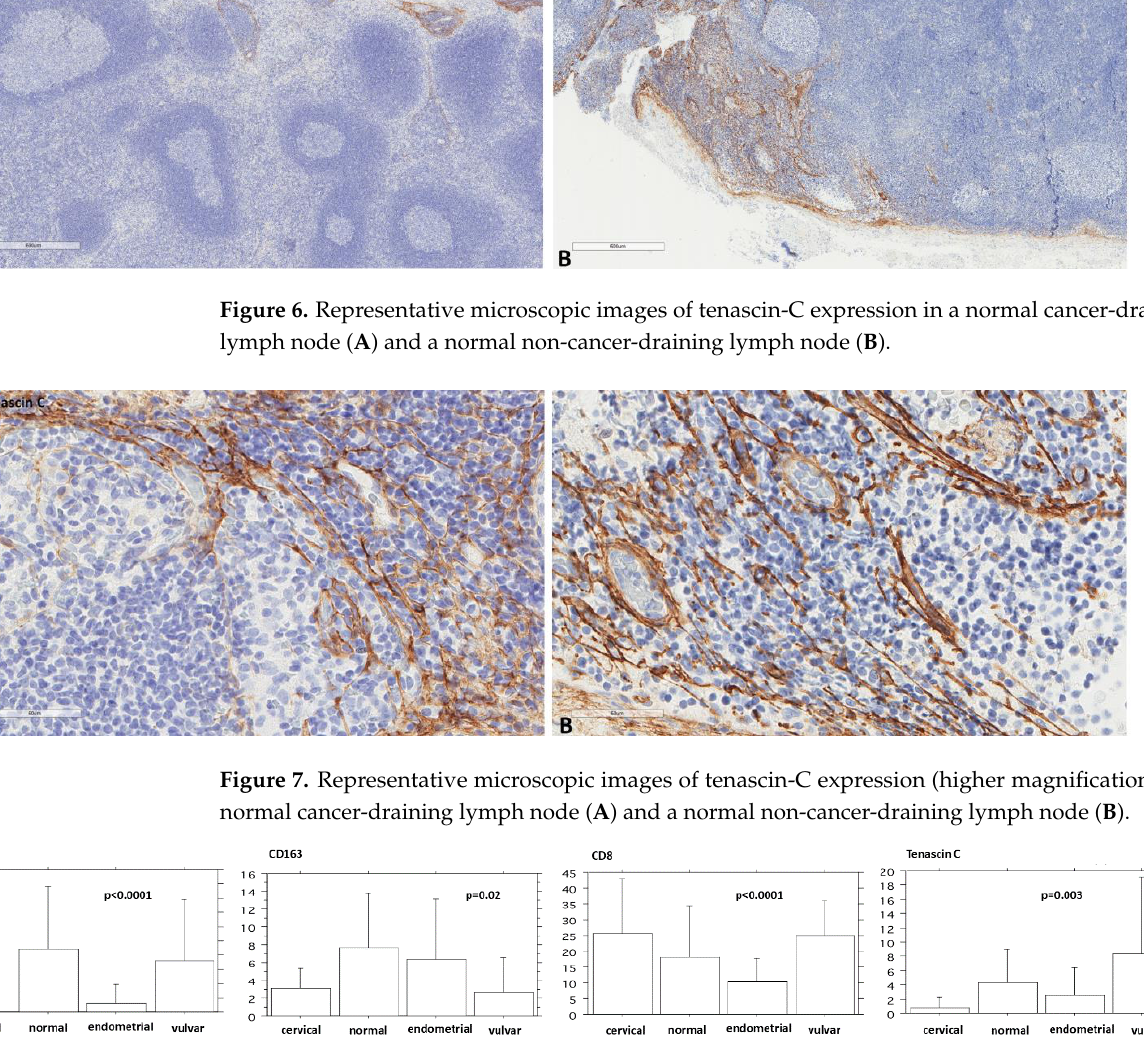
Figure 8. Differences in PD-L1, CD163, CD8, and tenascin-C between the various groups. Lymphovascular invasion and necrosis in the primary tumor were marginally asso- ciated with higher S100A8/A9 values in the non-metastatic regional lymph nodes (6.765 ± 6.21 vs. 4.018 ± 5.176, p = 0.0726 and 7.5 ± 6.816 vs. 4.136 ± 5.138 p = 0.0549, respectively)